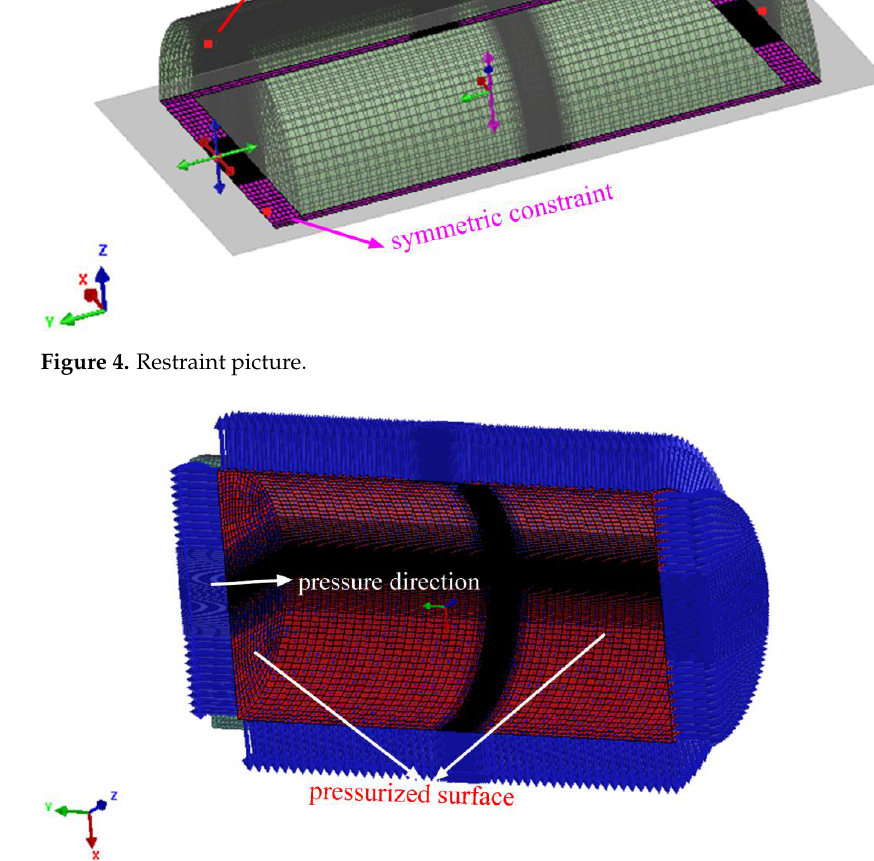
Figure 5. Pressure application. Figure 5. Pressure